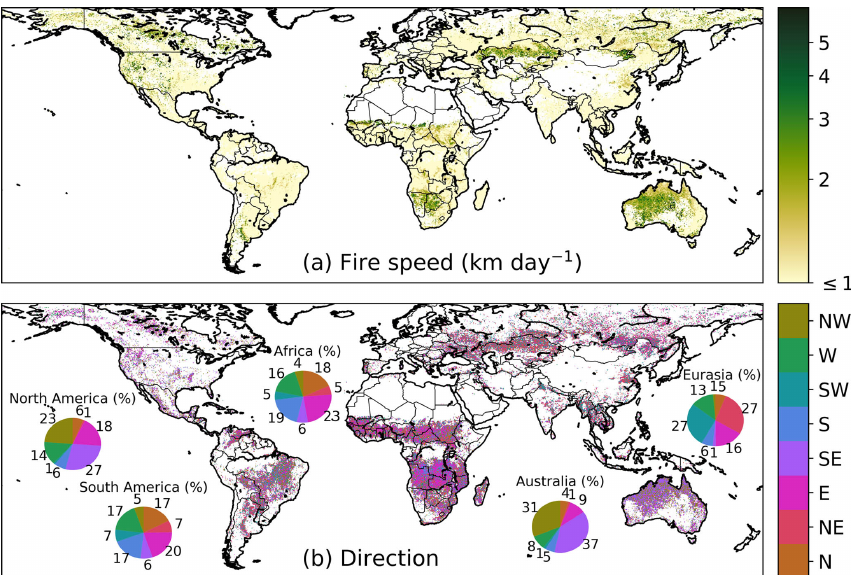
Figure 10. Average fire speed (a) and the dominant direction of fire spread (b) over the study period 2003–2016. For each 0.25 ◦ grid cell the direction was estimated as the dominant fire spread direction of fires larger than 10km 2 within the grid cell. We focused on larger fires ( ≥ 10km 2 ) to determine the dominant spread direction because large fires will generally express a clearer spatiotemporal structure of fire spread at a 500m daily resolution. Pie charts show the fraction of individual larger fires ( ≥ 10km 2 ) by dominant spread direction for each